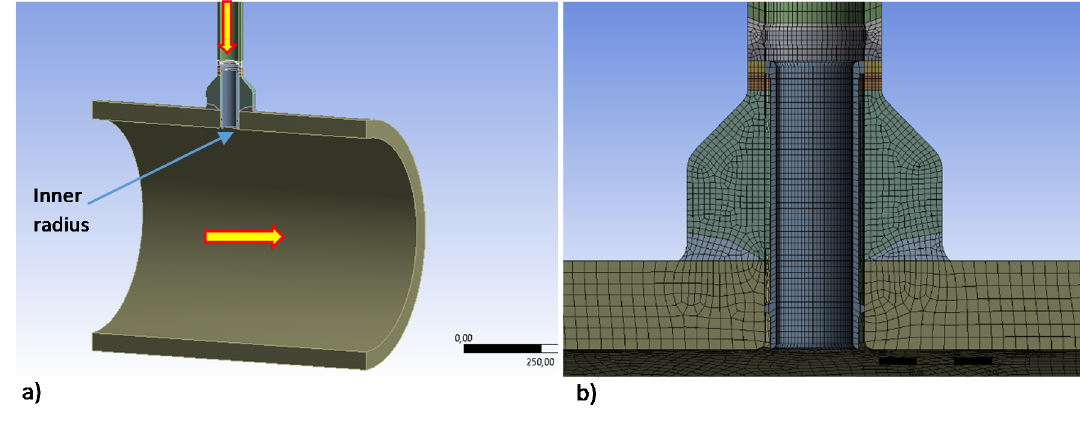
Figure 4. ( a ) Scheme of the charging nozzle and the cold leg, with the inner radius location. ( b ) FE model used in stress analysis. Yellow arrows indicate the direction of flow.